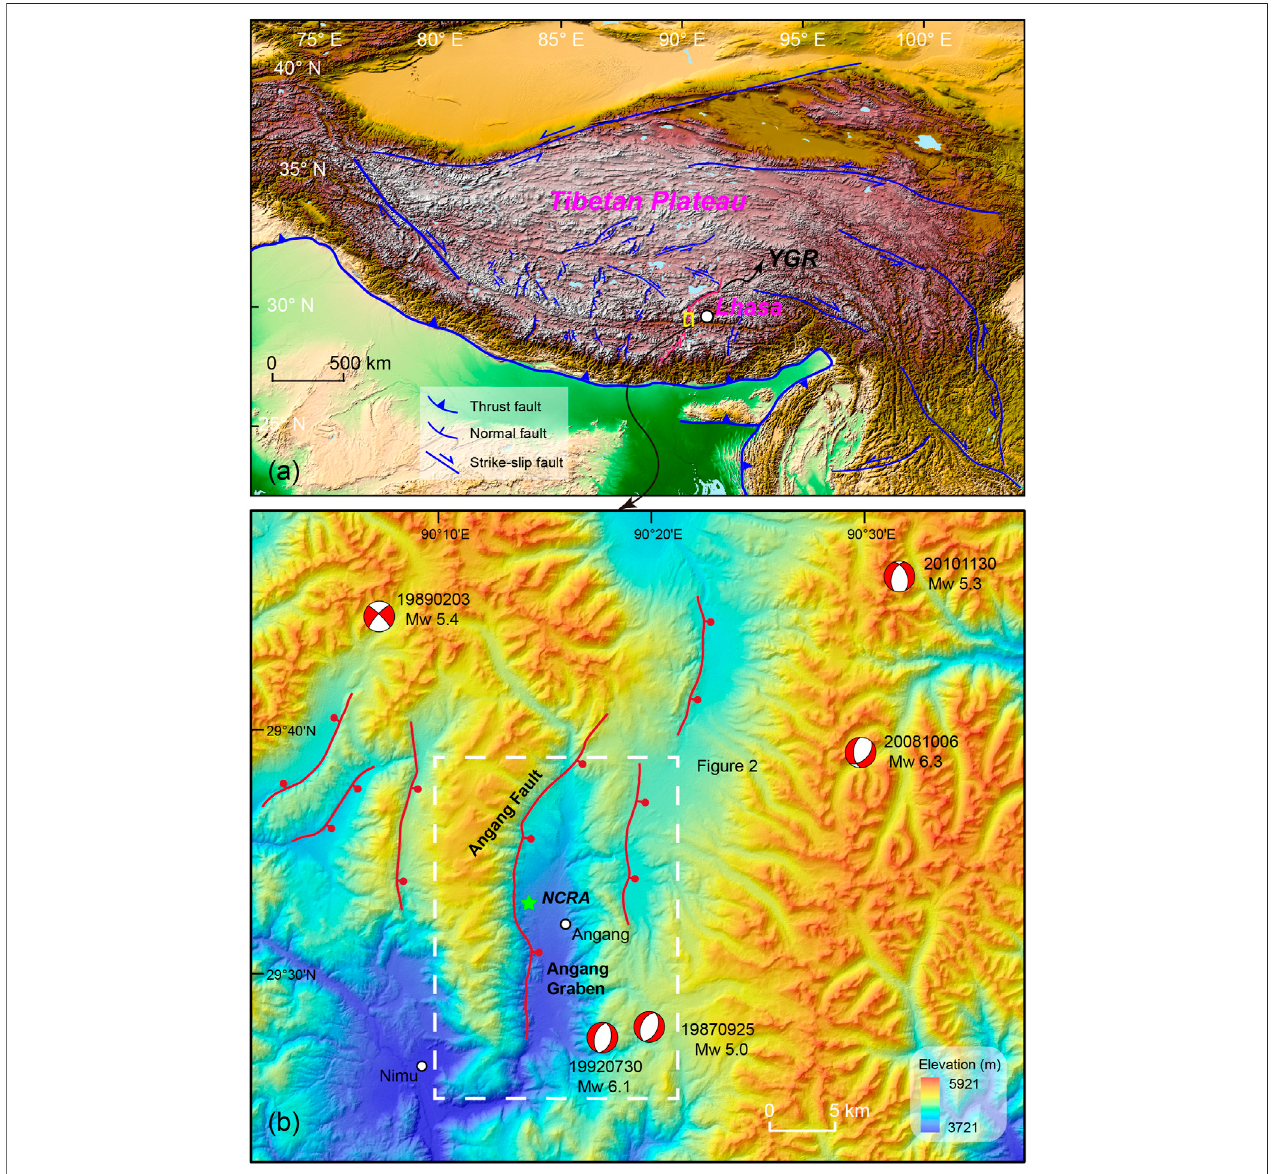
FIGURE 1 | (A) Simple tectonic map of the Tibetan Plateau. The pink fault line is the Yadong – Gulu rift (YGR). (B) The Nyixoi Chongco rock avalanche (NCRA) is located on the western side of the Angang graben. The focal mechanism solution data are from website https://www.globalcmt.org/CMTsearch.html (Accessed July 9,